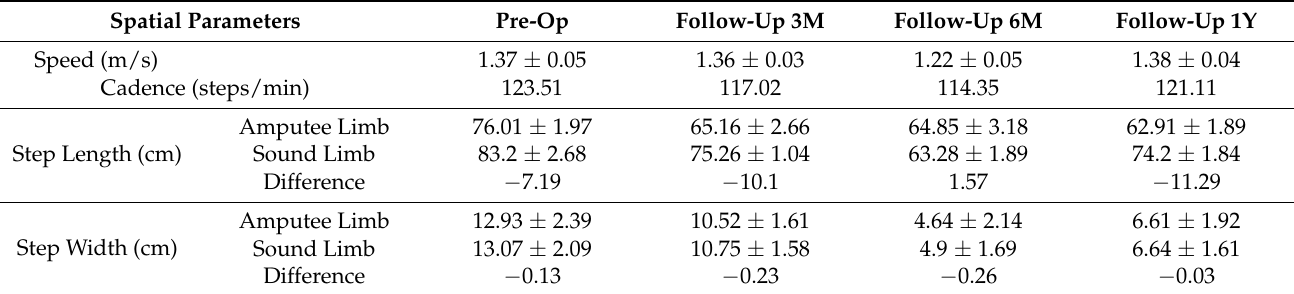
Table A1. Spatial gait parameters for the pre-operative gait analysis (socket-type prosthesis, ST) and for the follow-up gait analyses (osseointegrated prosthesis, OI). Data are presented for the self- selected speed gait as mean ± standard deviation. Note: “Difference” means Sound limb—Amputee limb variable.